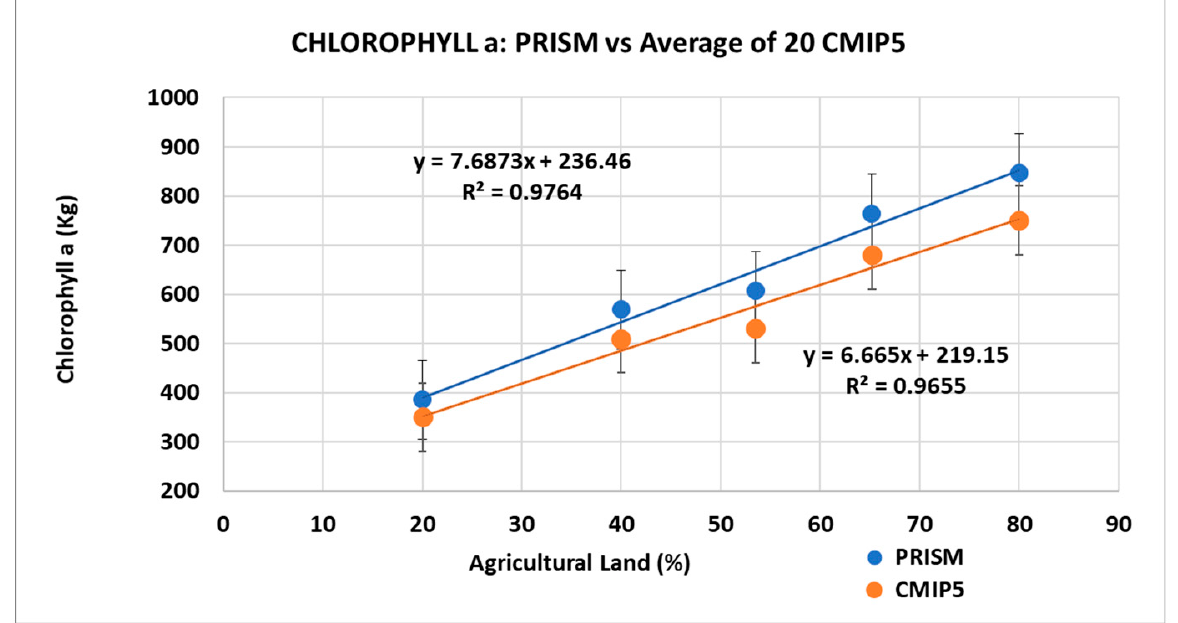
Figure 8. PRISM vs. 20 CMIP5 GCMs for total chlorophyll a.